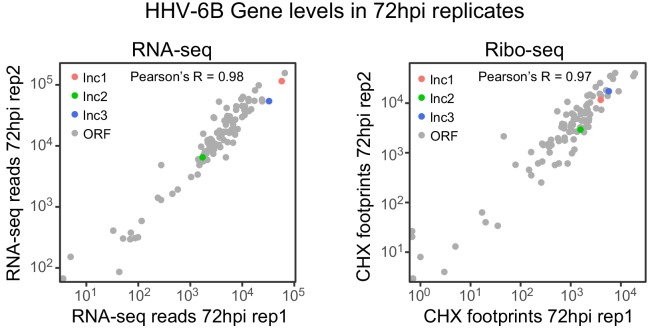
RNA abundance and ribosome footprint coverage correlate well between replicates.Scatter plot of RNA-seq and CHX Ribo-seq reads of canonical HHV-6 ORFs and novel lncRNAs. Gray dots represent ORFs, colored dots represent lncRNAs (lncRNA1 in red, lncRNA2 in green and lncRNA3 in blue).